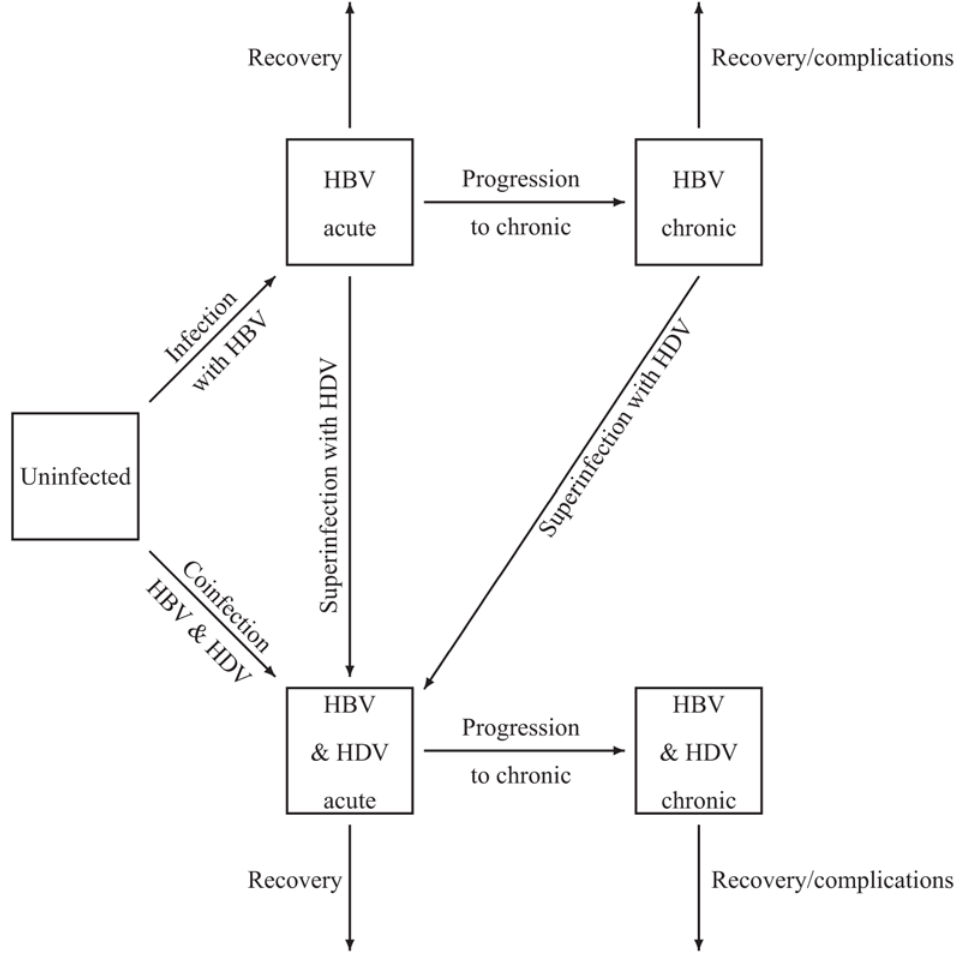
Figure 1. Model for the transmission of hepatitis B virus (HBV) and hepatitis D virus (HDV).